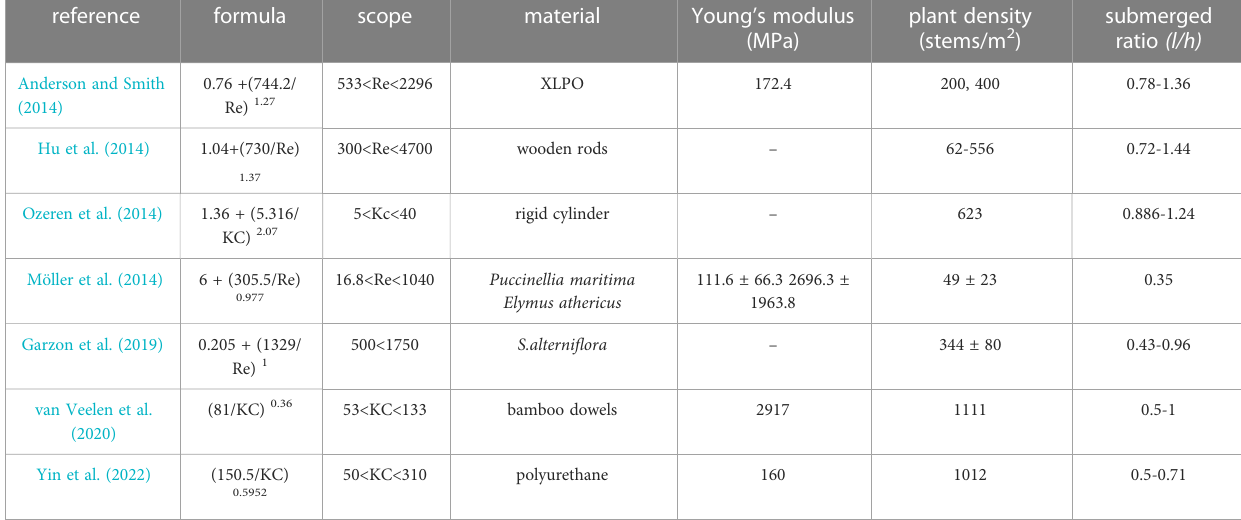
TABLE 4 Formulas of the bulk drag coef fi cient ( C D ) for the wave attenuation by standing cylinder-type vegetation.